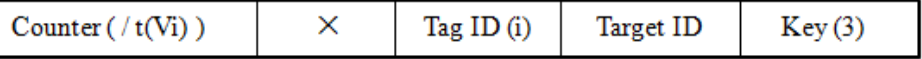
Figure 13. RFID tag’s signal format for channel sensing.